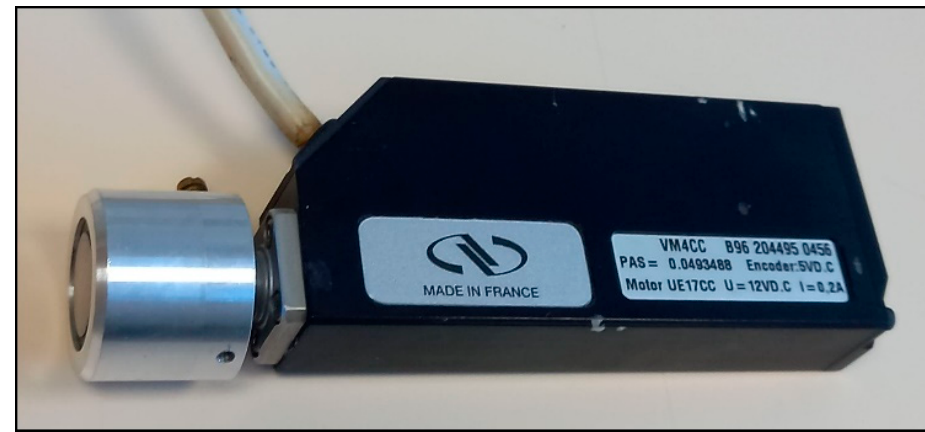
Figure 15. Actuator of the push force control system by Micro ‐ Contrôle Corp.